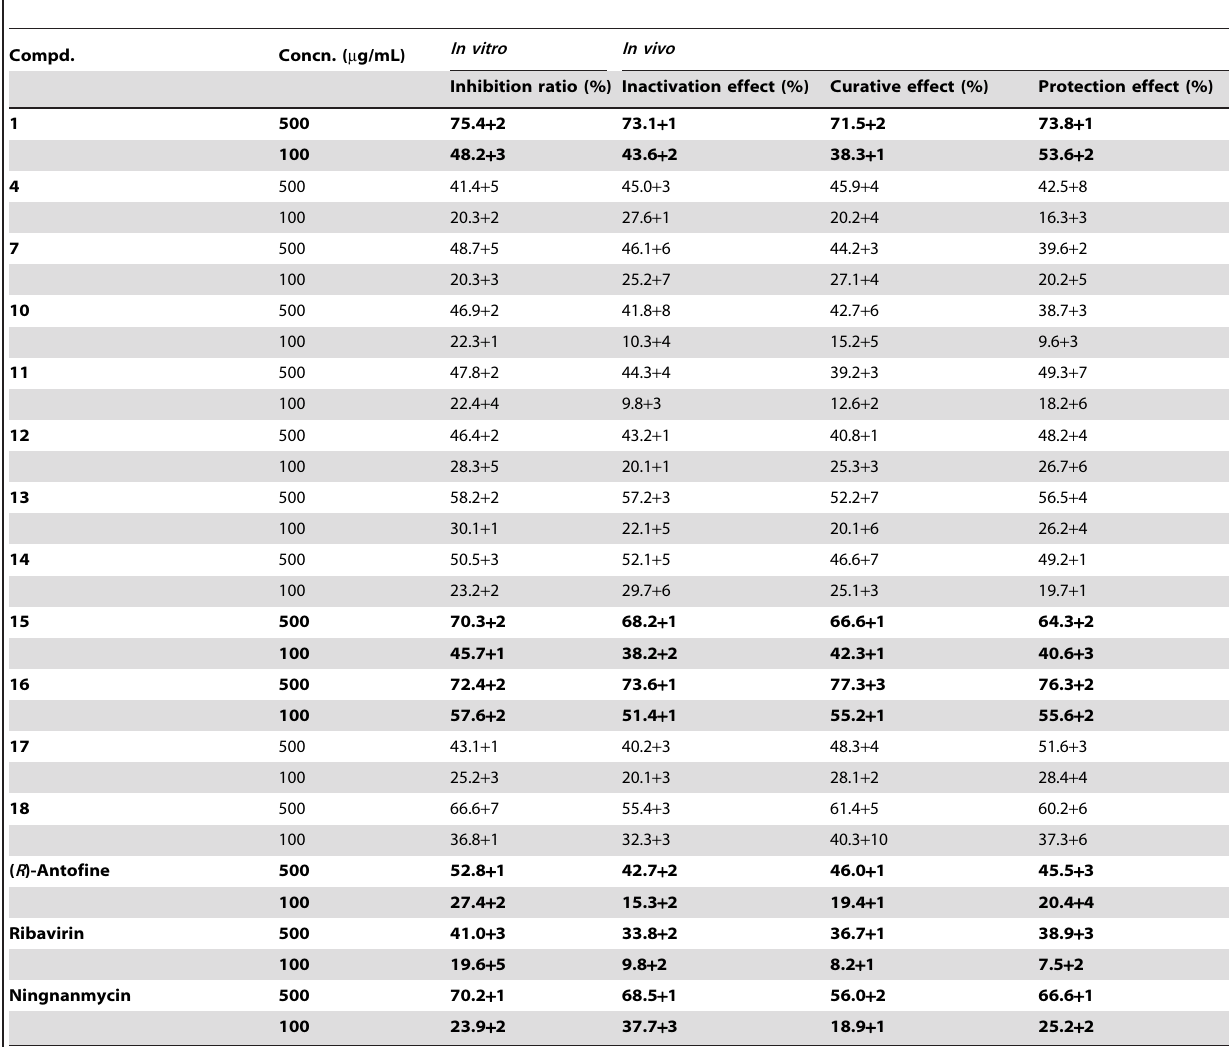
Table 1. In vitro and in vivo anti-TMV activity of racemic phenanthroquinolizidine alkaloids 1, 4, 7, and 10–18.